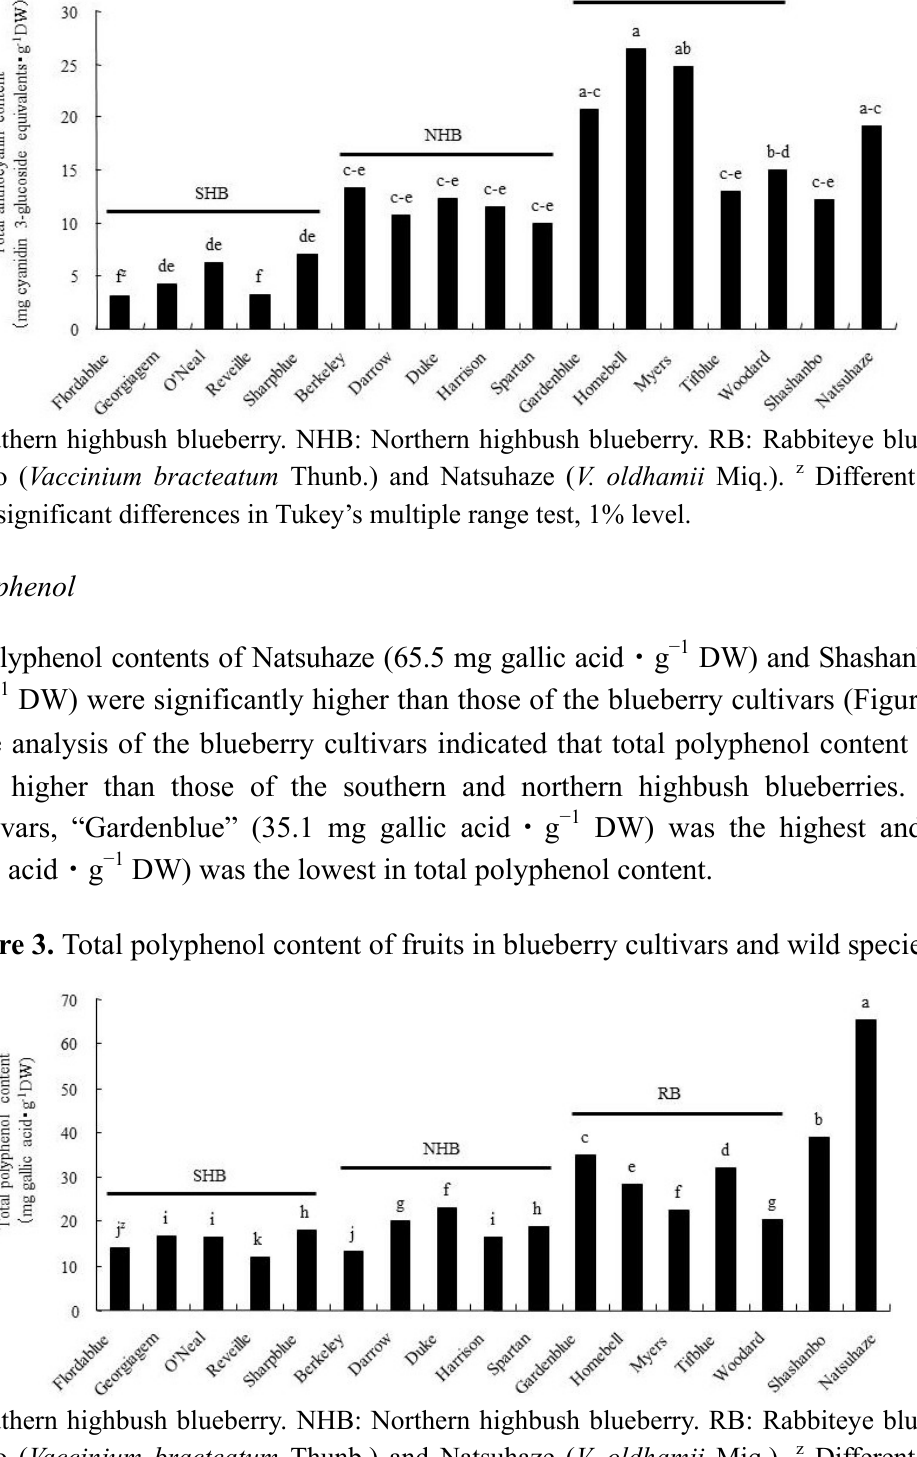
Figure 2. Total anthocyanin content of fruits in blueberry cultivars and wild species.